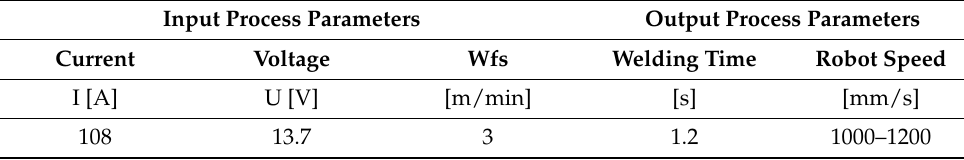
Table 1. WAAM process parameters.